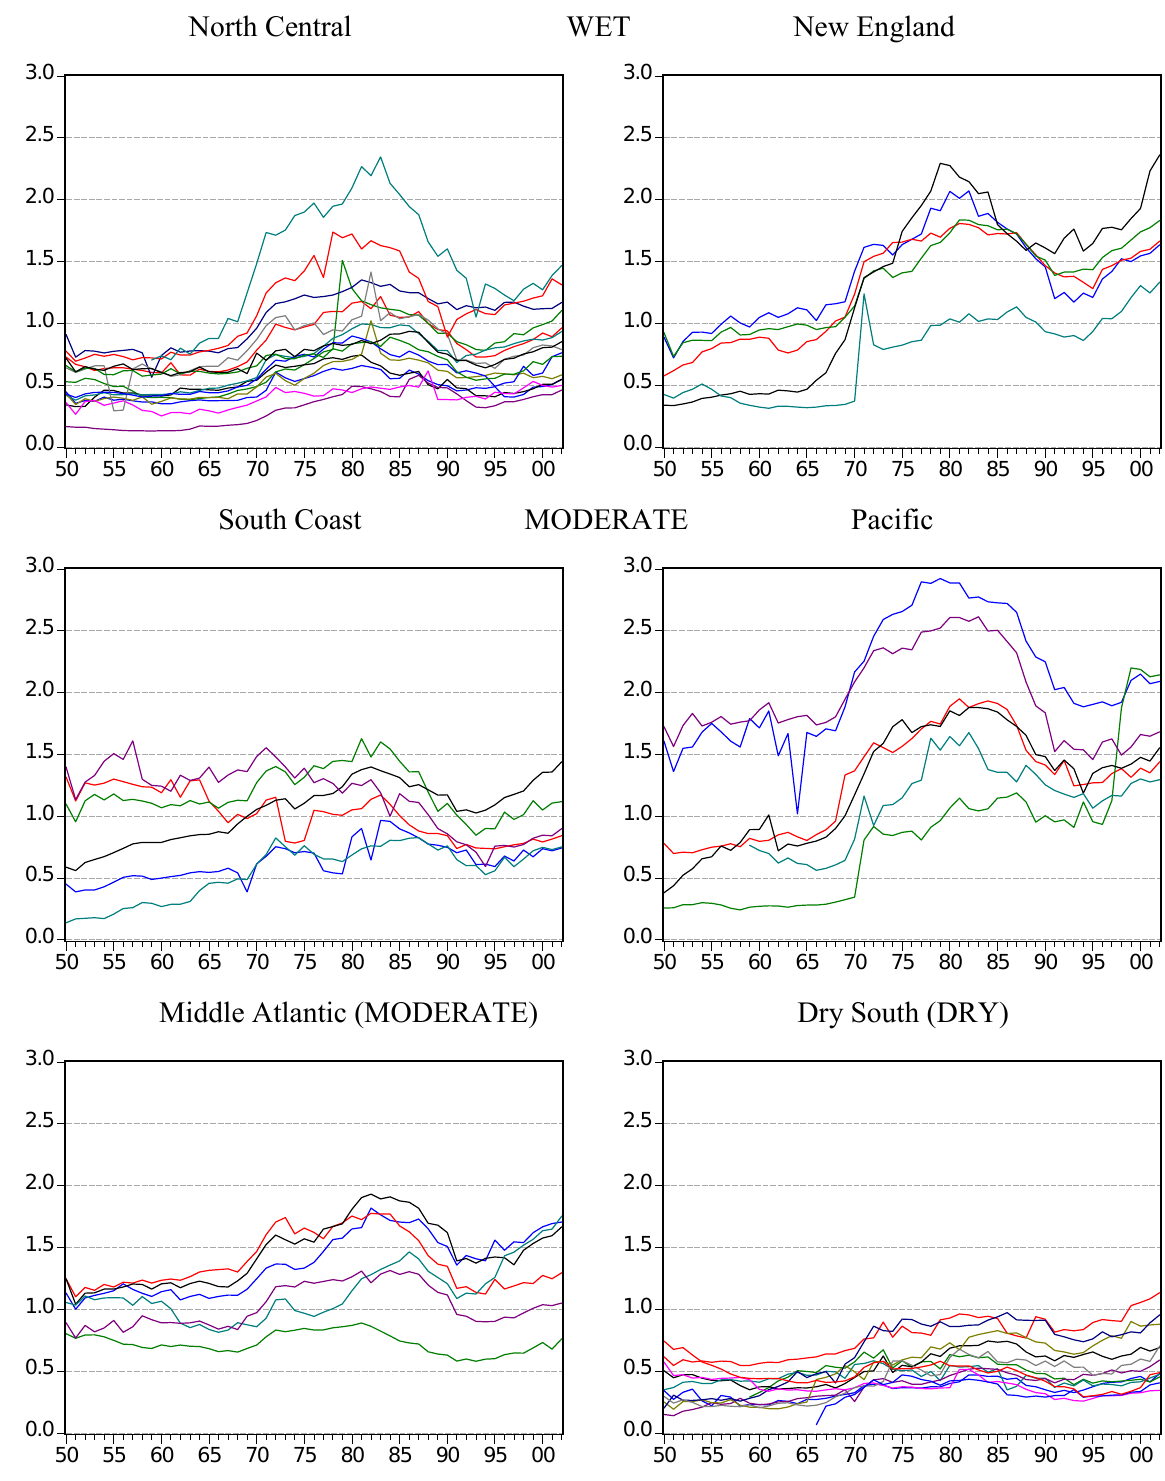
Figure 4. Apparent consumption of wine in liters of ethanol per capita aged 15+ by state in groups over the years from 1950 to 2002. North Central WET New